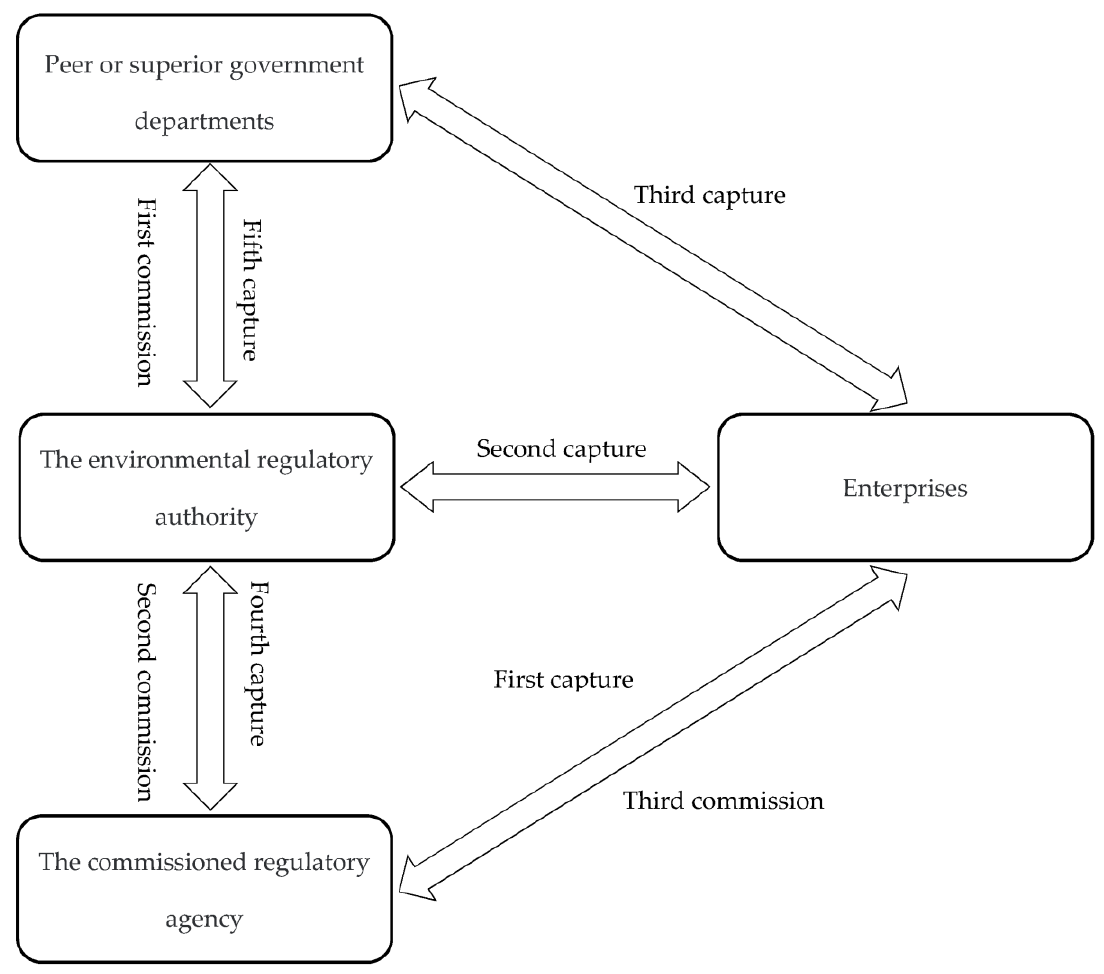
Figure 1. The triple-layer principal—agent model of environmental regulation practices in China.